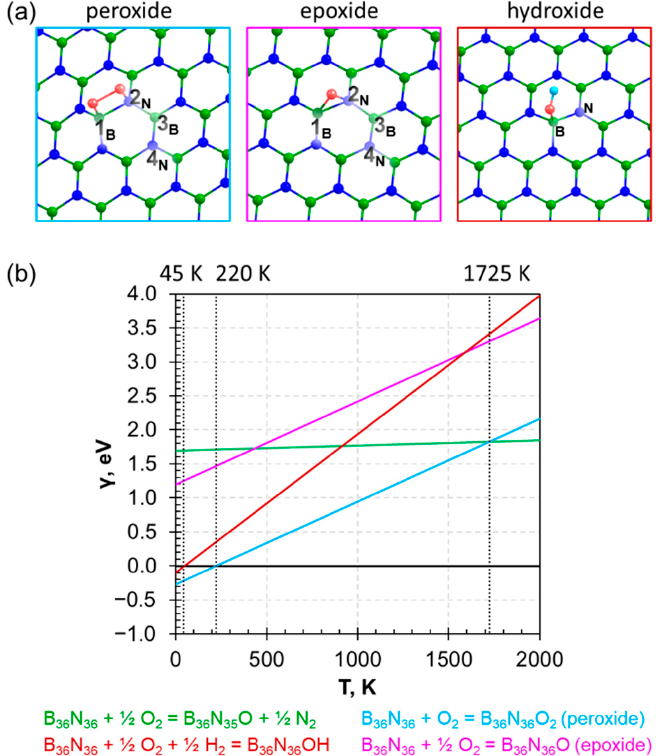
Figure 2. ( a ) Fragment of atomic structure of h − BN with peroxy − ( left ), epoxy − ( middle ) and hydroxy − ( right ) group in lattice. Boron, nitrogen, and oxygen atoms are marked by green, blue, and red circles, respectively. ( b ) Dependence of surface free energies on temperature. The color of the lines corresponds to the reactions in the figure below. The crossing lines and corresponding temperature indicated by vertical dotted lines.